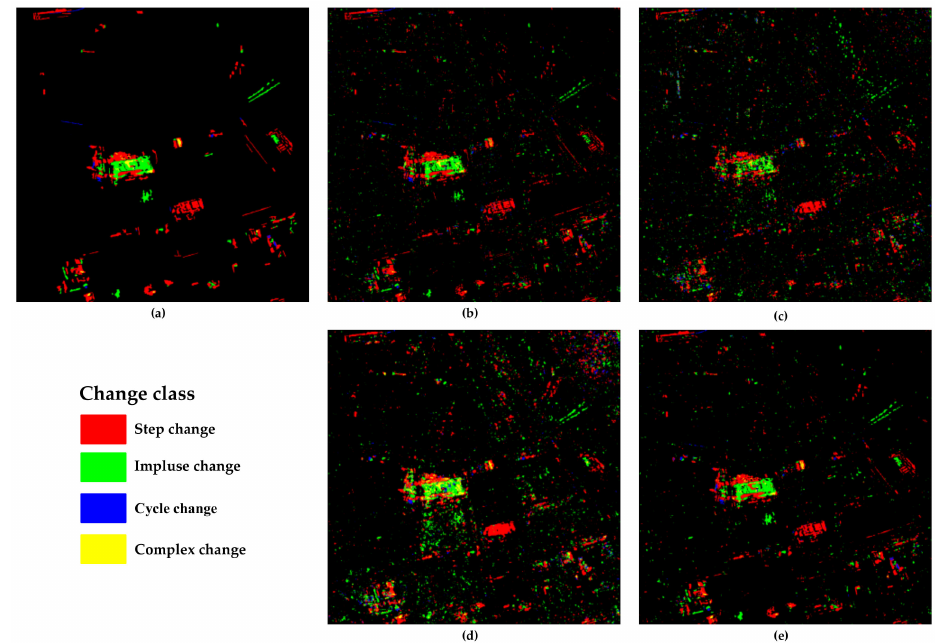
Figure 8. The time-series change detection and classification results using realistic data: ( a ) Ground truth map; ( b ) NORCAMA; ( c ) NOR_KLD; ( d ) NOR_KS2; ( e ) Proposed